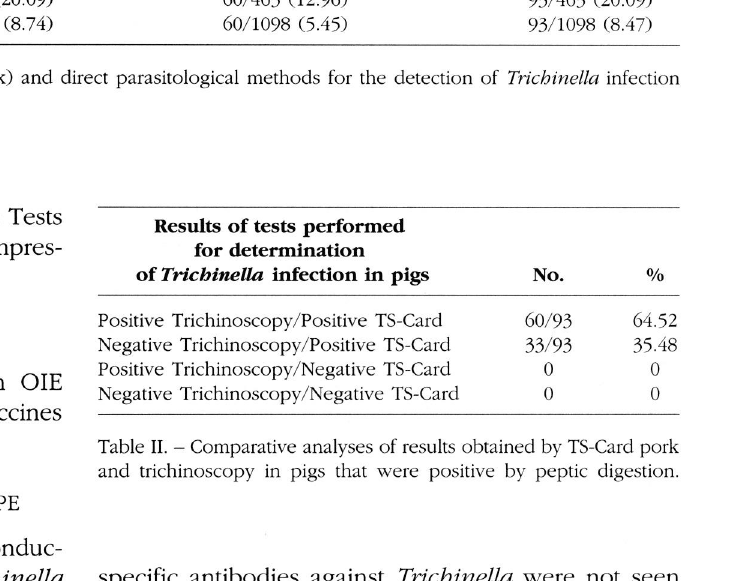
Table II. - Comparative analyses of results obtained by TS-Card pork and trichinoscopy in pigs that were positive by peptic digestion.